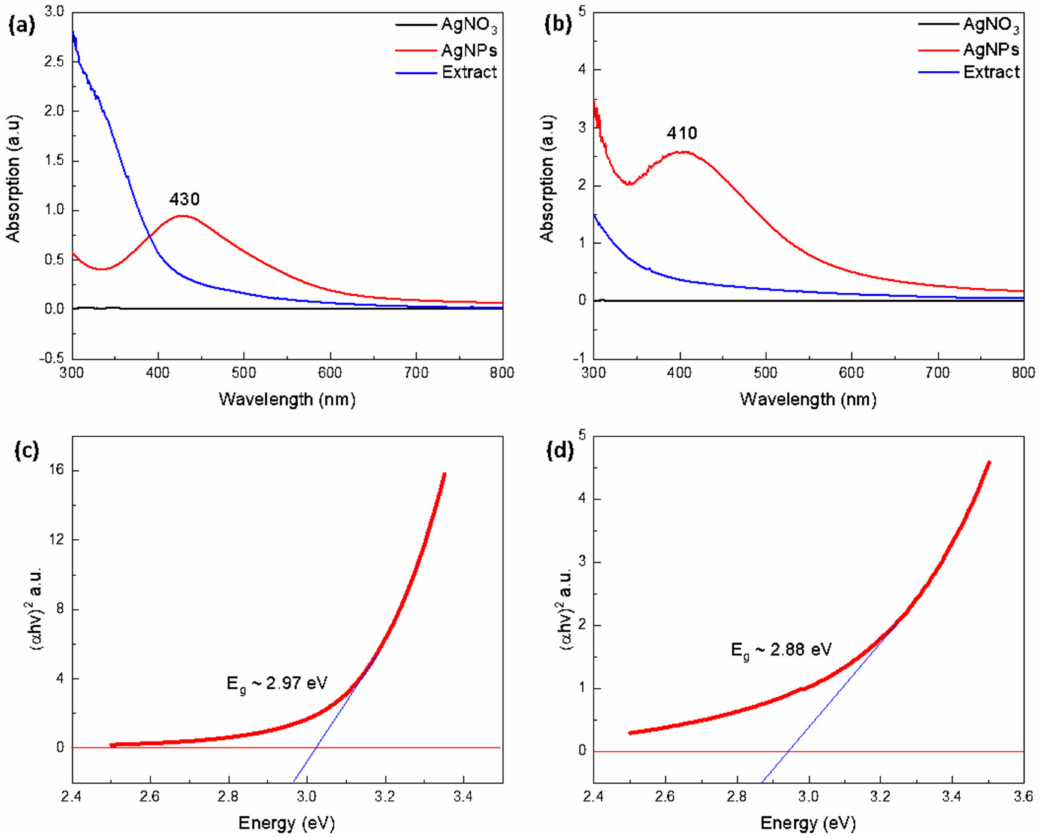
Figure 5. UV-Vis absorption spectrum for mediated AgNPs of ( a ) leaf extract, ( b ) fruit extract, and optical bandgap of ( c ) leaf extract, and ( d ) fruit extract. Note: Blue lines in ( c , d ) indicate the slopes which are used to find the optical bandgap ( E g ) values (2.97 and 2.88 eV),